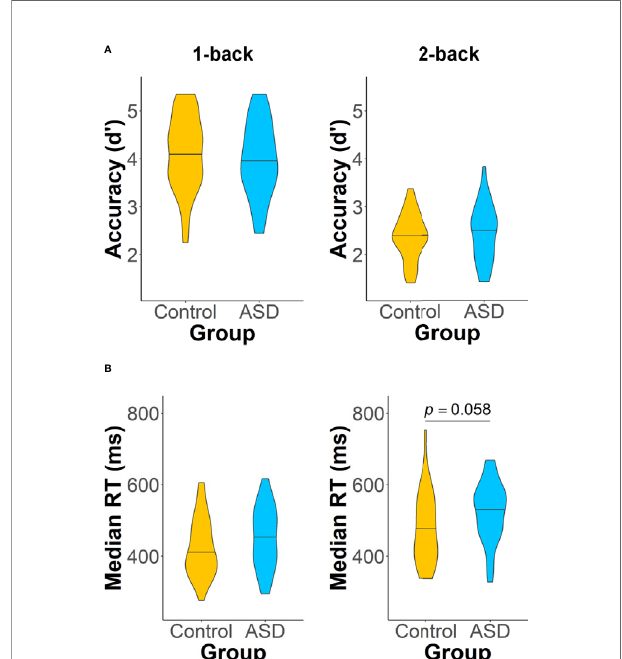
FIGURE 3 | Accuracy (A) and median RT (B) on the two loads of the n -back task: 1-back (left panel) and 2-back (right panel). Adults with autism spectrum disorder (ASD) showed a trend of having longer median RTs than control adults on the 2-back task ( p = 0.058). Analyses of all other task performance measures did not reveal any signi fi cant group